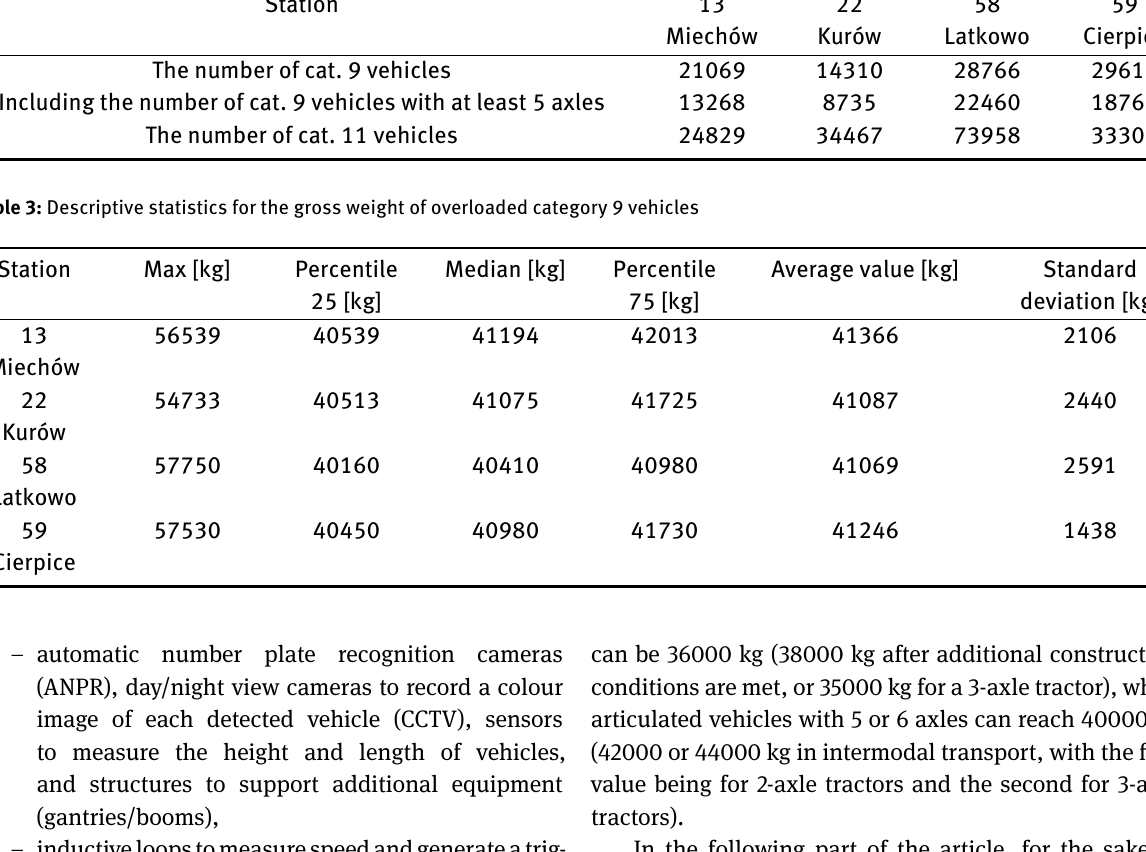
Table 2: Number of category 9 and 11 vehicles registered by selected HS-WIM stations during the measurement period Station The number of cat. 9 vehicles Including the number of cat. 9 vehicles with at least 5 axles